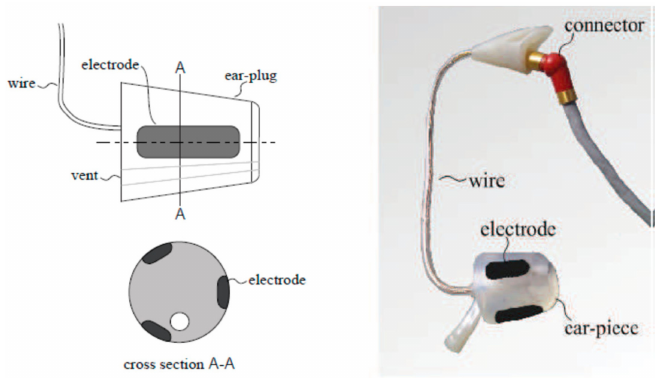
Figure 2. Generic in-ear EEG prototype [37]. The left side illustrates a drawing whereas the right side illustrates a model prototype.